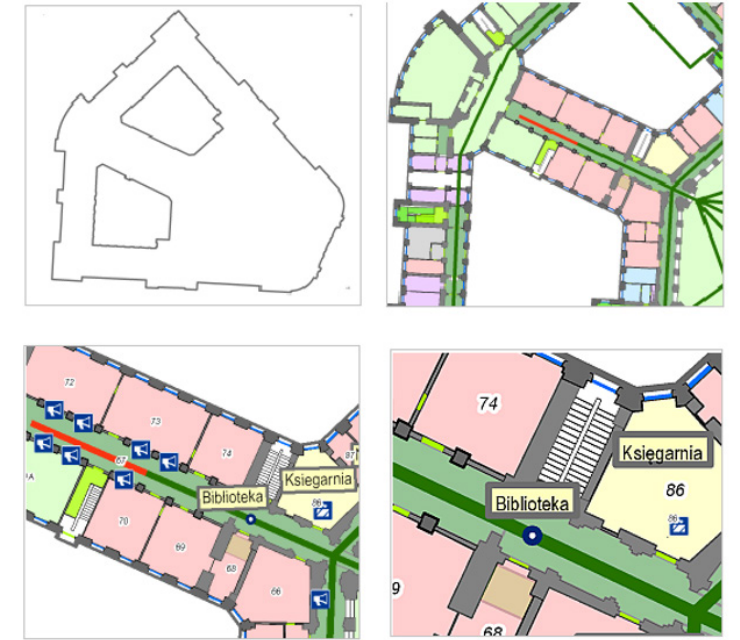
Fig. 3. The multi-scale geovisualization of the interior of a building for navigation